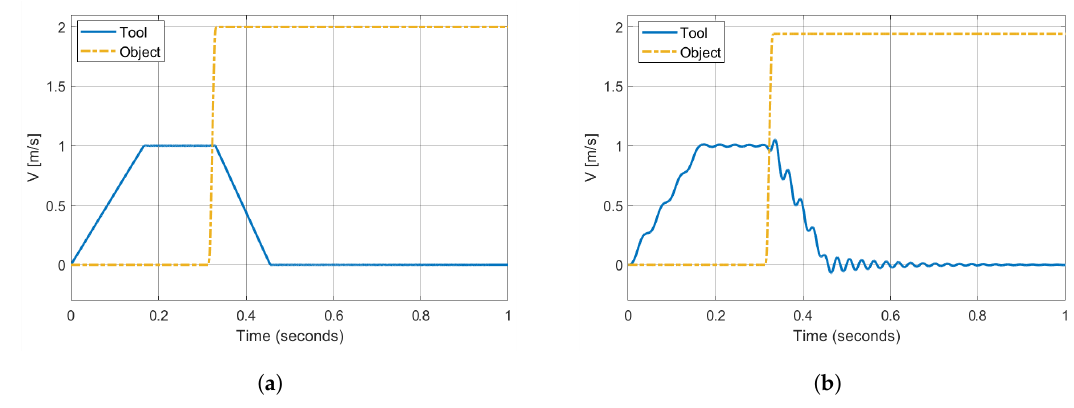
Figure 13. Time history of tool and object velocity. ( a ) Robot with rigid joints; ( b ) robot with compliant